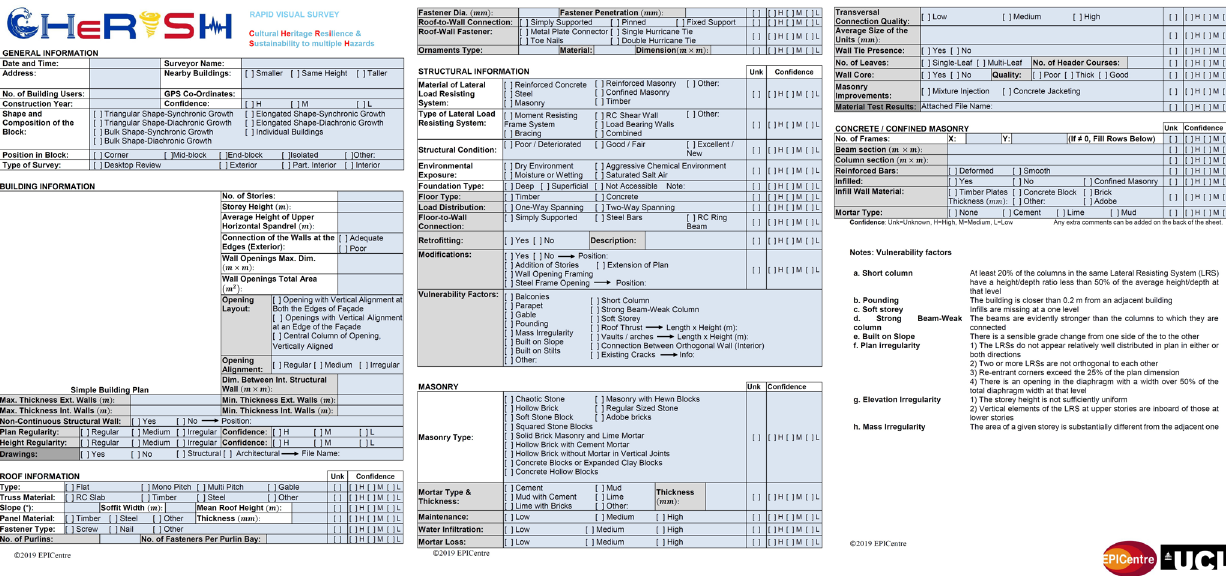
Figure 2. CHeRiSH RVS form. The full RVS form in its original 3 × A4-size pages is available online as supplemental material to this